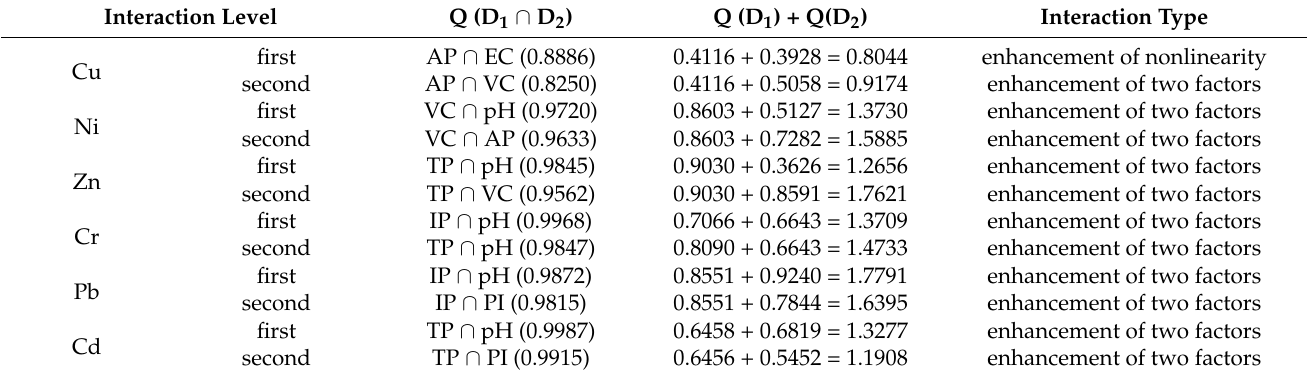
Figure 6. Comparisons of explanatory power between heavy metals in sediment of Inner Mongolia section of Yellow River. Table 3. Interaction of spatial differentiation risk factors of heavy metals in sediments from the Inner Mongolia section of the Yellow